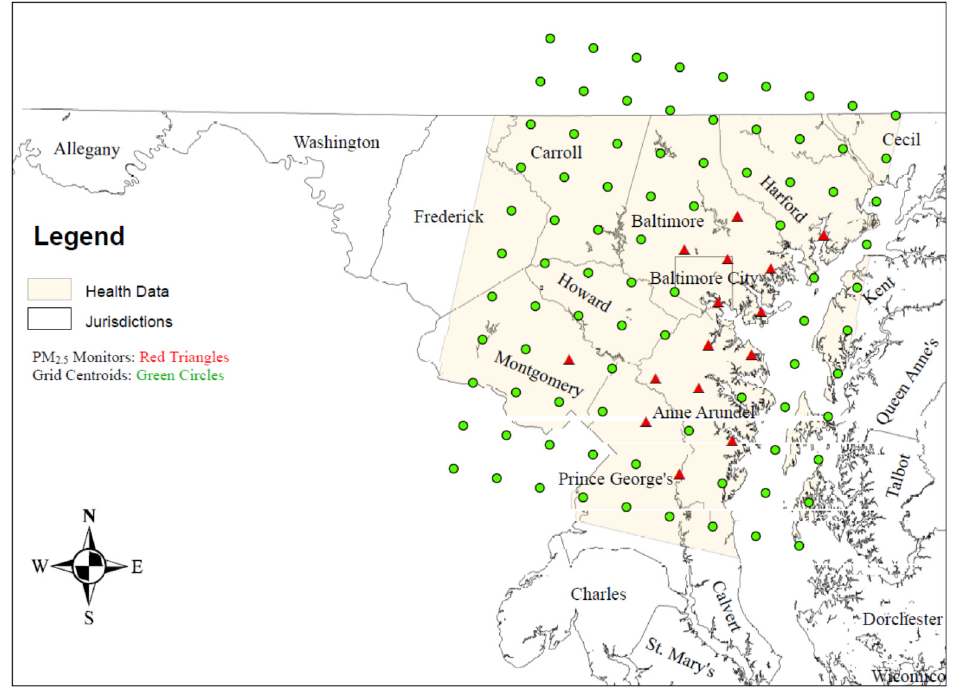
Figure 1. Maryland choropleth map of the Baltimore study area. Map from Reference [80].